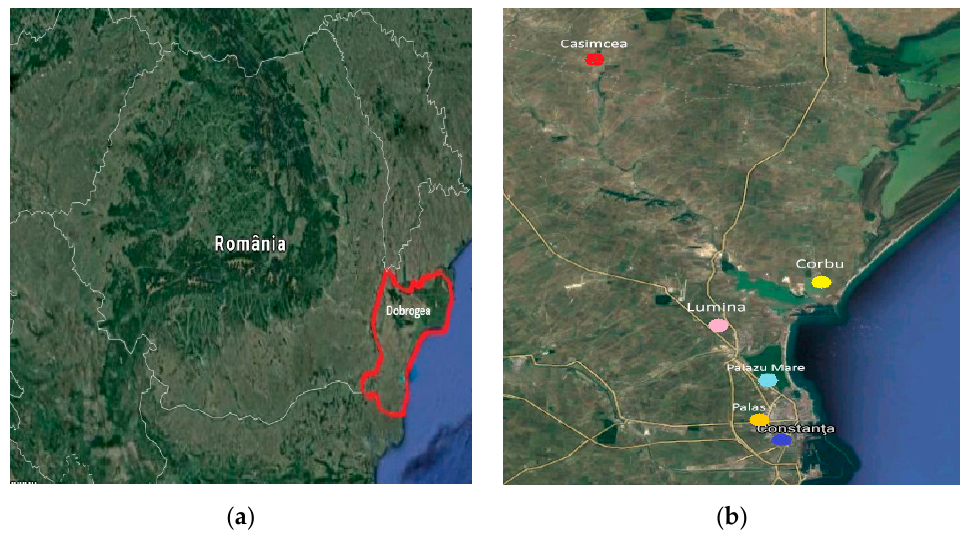
Figure 1. ( a ) Dobrudja region from Romania; ( b ) map of groundwater sampling locations in the region of Dobrudja (Constanta, Palas, Palazu Mare, Lumina, Casimcea, Corbu).